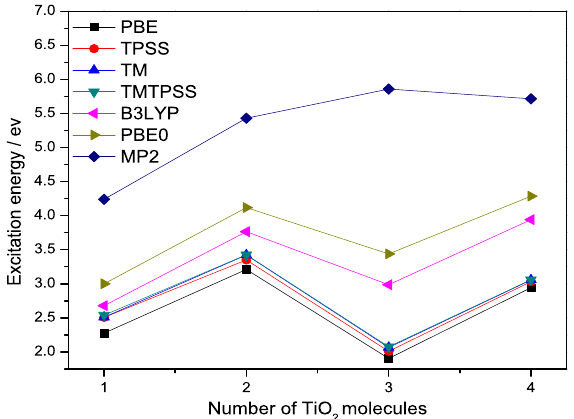
Figure 2. Lowest singlet excitation energies (eV) of (TiO 2 ) n ( n = 1–4) calculated with different methods at 6-311++G(3 df ,3 pd ) basis